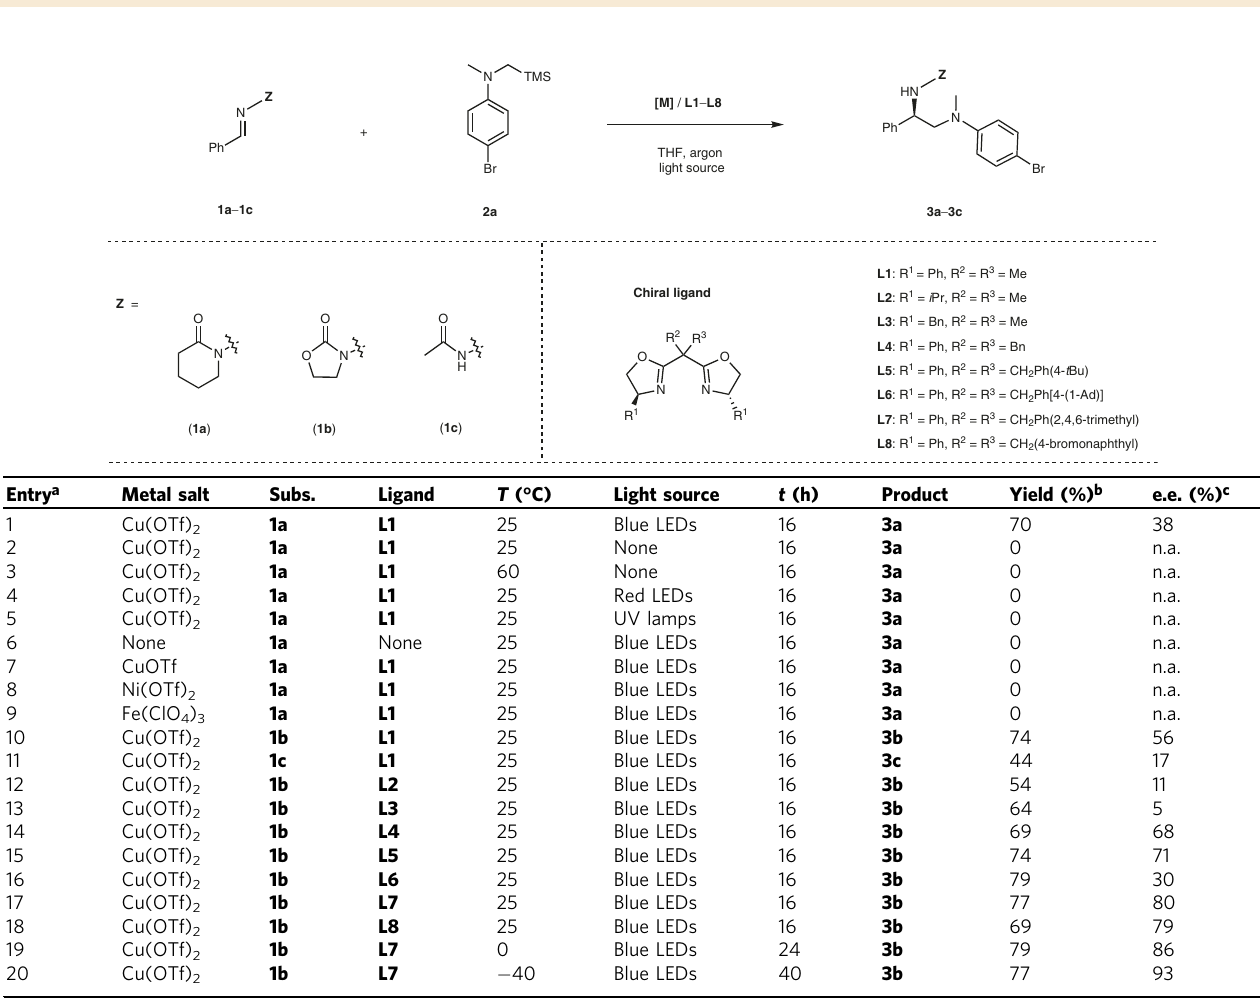
Table 1 Optimization of the reaction